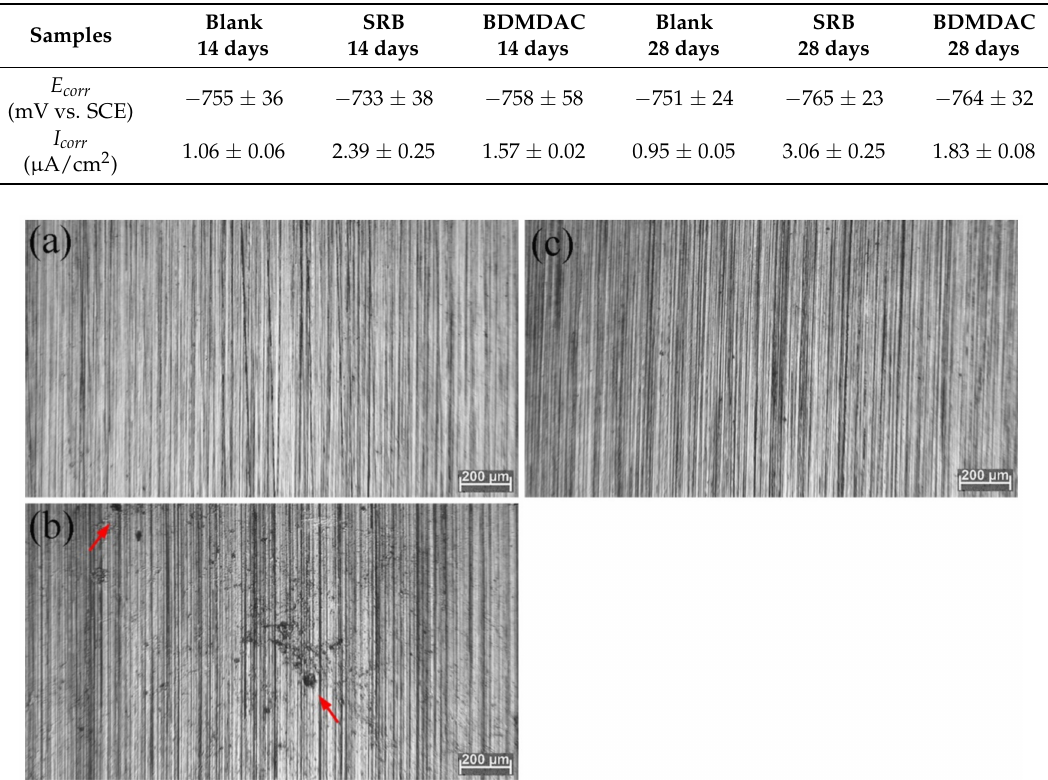
Table 2. Corrosion potential and corrosion current density measured according to potentiodynamic polarization curves after 14 and 28 days of immersion.